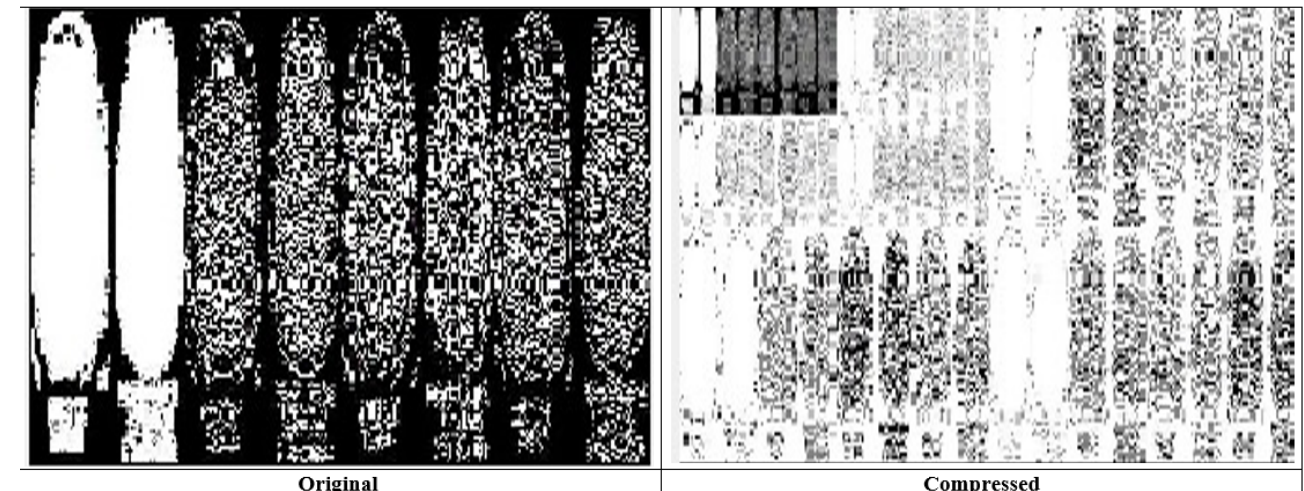
Figure 4. Applying DWT.